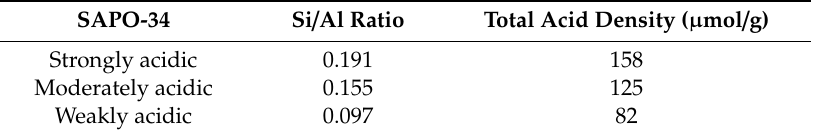
Table 1. Quantitative acidic